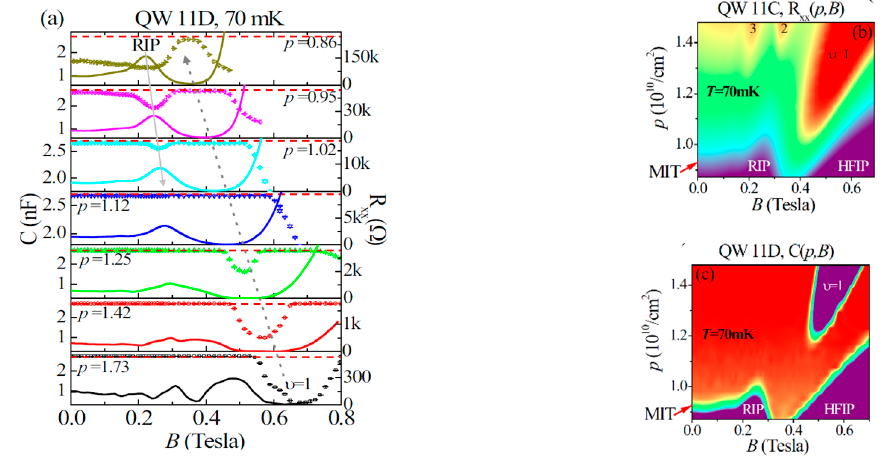
Figure 5. ( a ) Capacitance (symbol) and resistance (line) vs. perpendicular magnetic field at several hole densities in a 10 nm wide GaAs quantum well system. ( b ) The phase diagram viewed in the longitudinal resistance map at 70 mK. ( c ) The phase diagram viewed in the capacitance map at 70 mK. Figure from Reference [10].